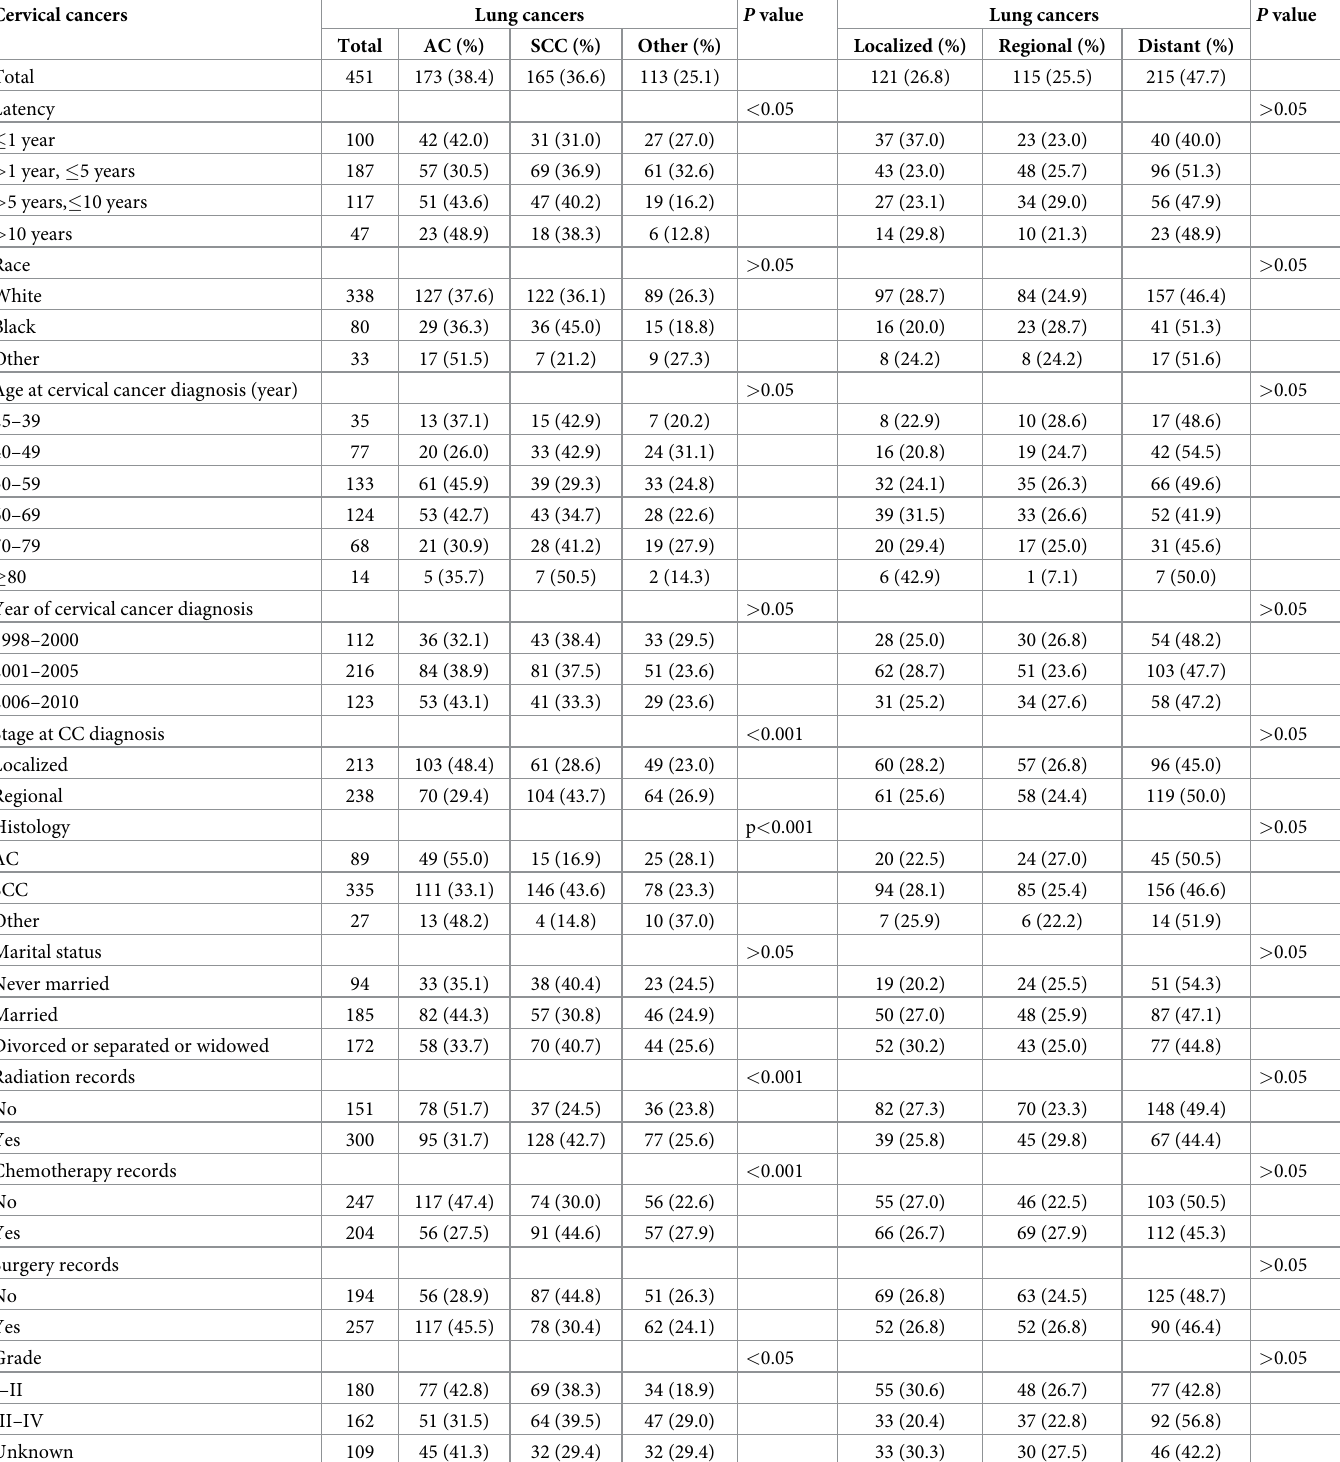
Table 2. Impact of demographic and clinical features of cervical cancer on pathological types and clinical stages of lung cancer. Cervical